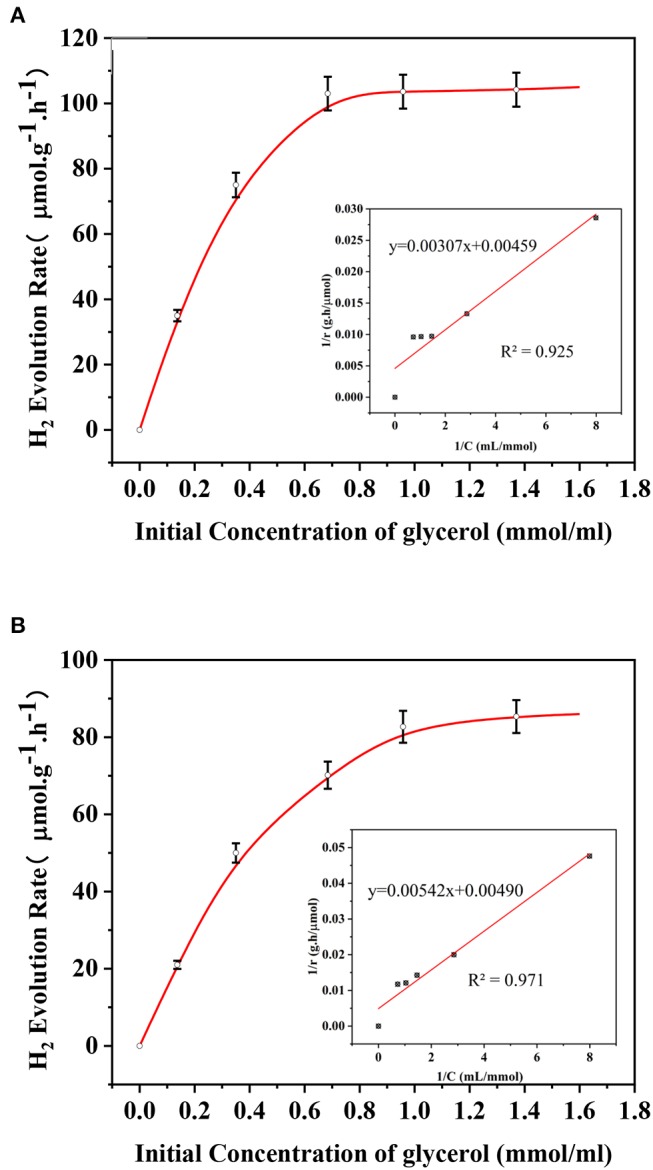
Initial H2 evolution rate curve (A) with stirring (B) without stirring and the fitting plot of 1/r vs. 1/C in the inset.